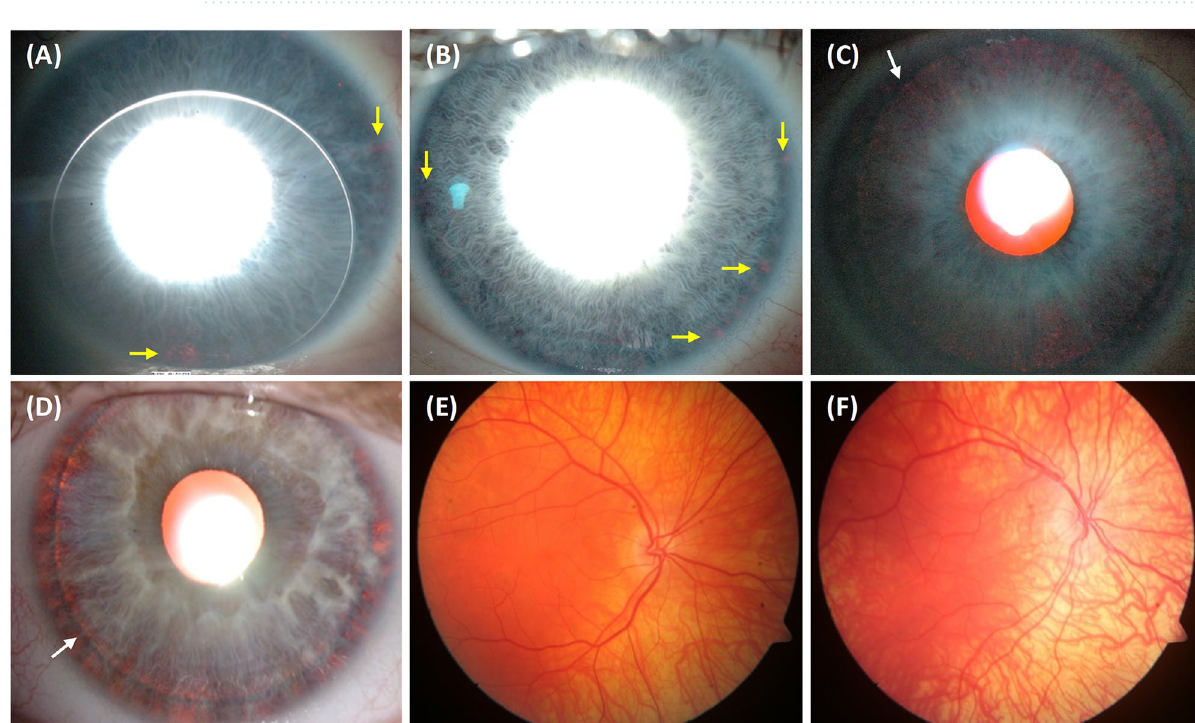
Figure 4. Iris and fundus photos. Spectrum of iris transillumination defects (TID) seen in the nystagmus families ( A – D ). Specks of TID (yellow arrows) seen in F1:I-1 ( A ) and F4:II-3 ( B ). Note the rigid gas permeable contact lens in ( A ). Higher grades of TID are seen in F4:I-2 ( C ) and F4:II-1 ( D ). There is diffuse TID with lens visible (white arrow). Varying degrees of fundus hypopigmentation in F4:I-2 ( E ) and F4:II-1 ( F ). In both fundus images there is visible choroidal vasculature predominantly in the posterior pole ( E ) and extending to the mid- periphery and towards the macula ( F